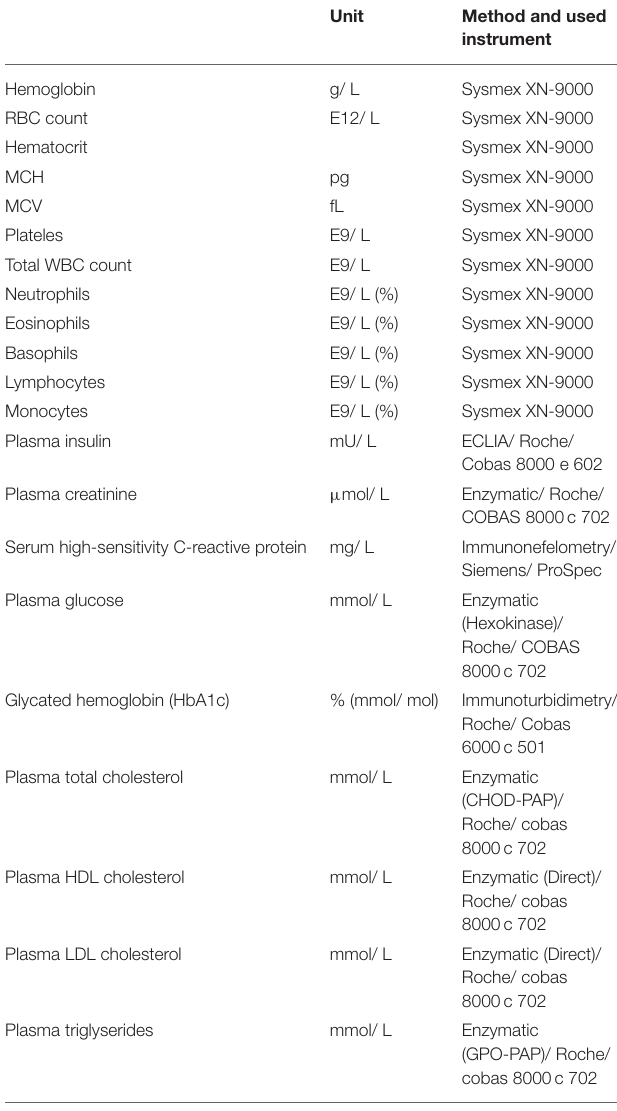
TABLE 3 | Laboratory measurements performed at ASIC-E4 baseline and 4-year follow-up.